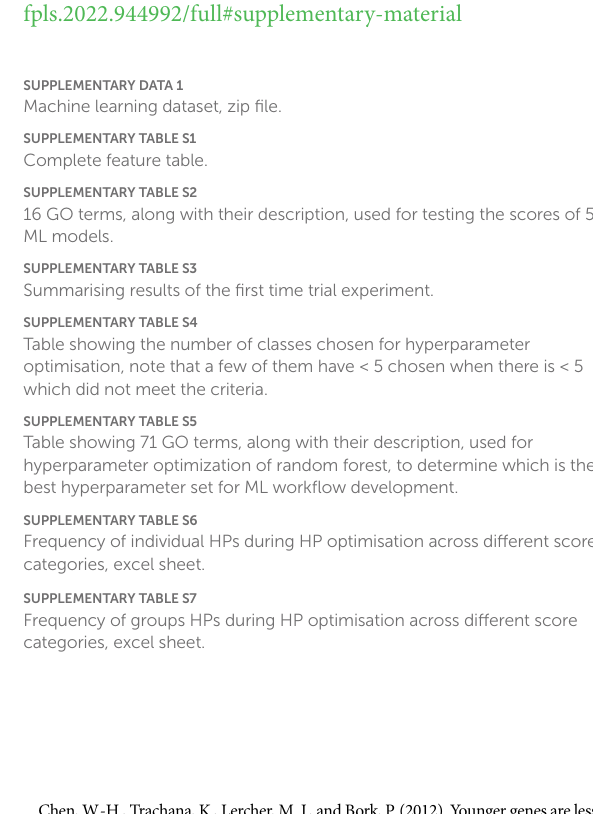
SUPPLEMENTARY TABLE S5 Table showing 71 GO terms, along with their description, used for